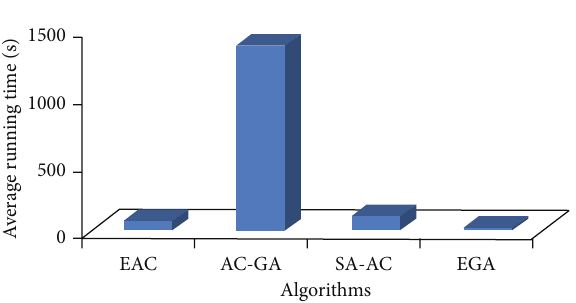
Figure 23: Comparison of average running time on map